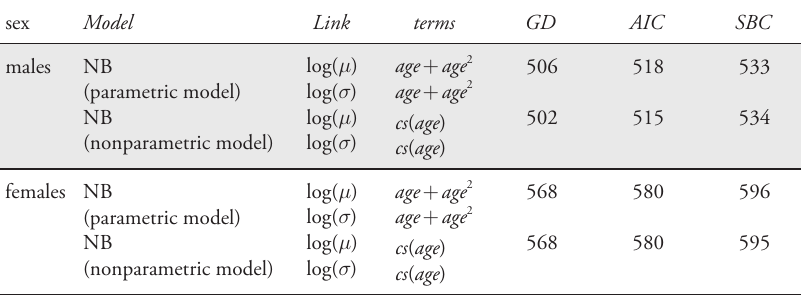
Table 4: Quality of fit statistics using